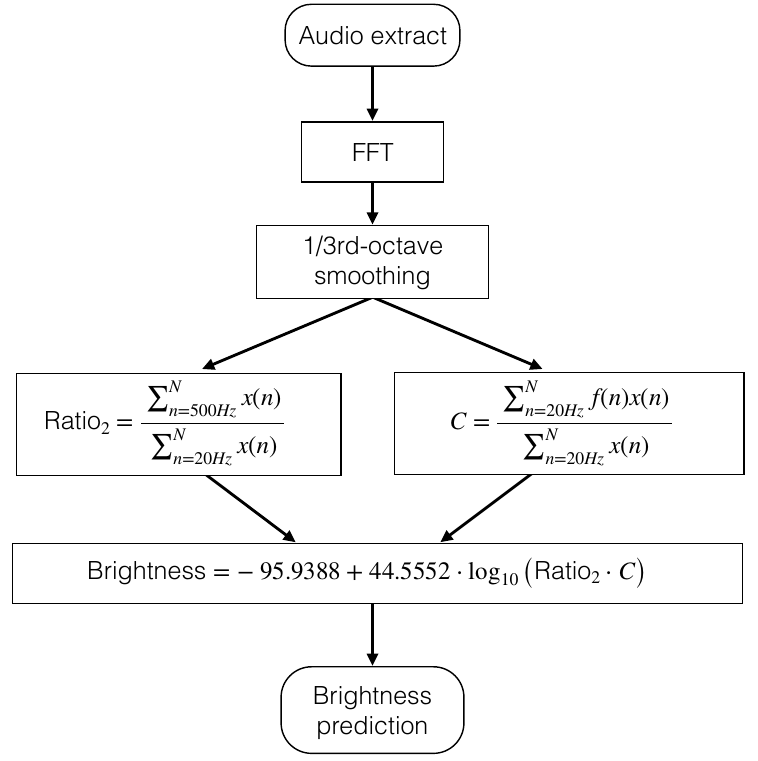
Figure 3. Flow chart of the developed brightness model (FFT = Fast Fourier Transform).